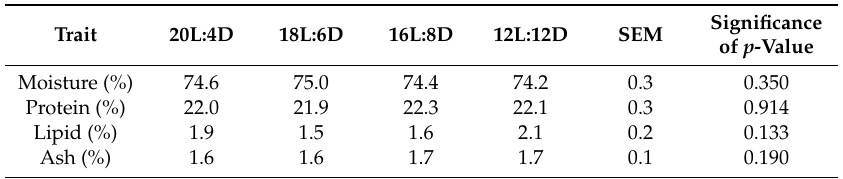
Table 3. E ff ect of photoperiod on proximate composition (wet-matter basis) of broiler fillet ( M. Pectoralis major ) muscles ( n = 6 /